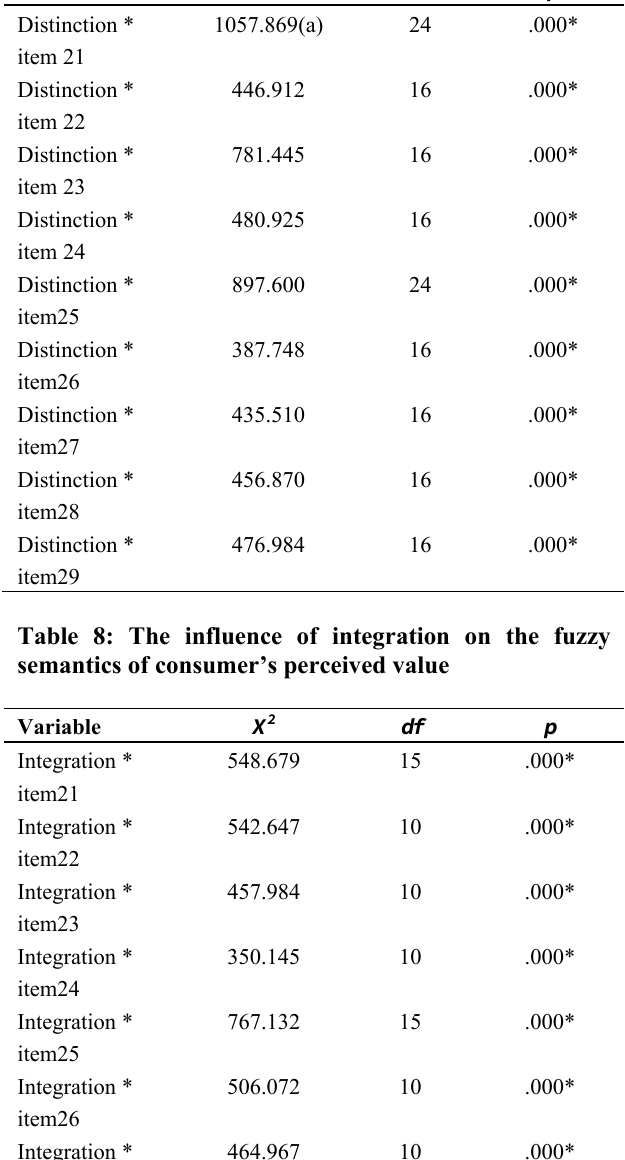
Table 7: The influence of distinction on the fuzzy